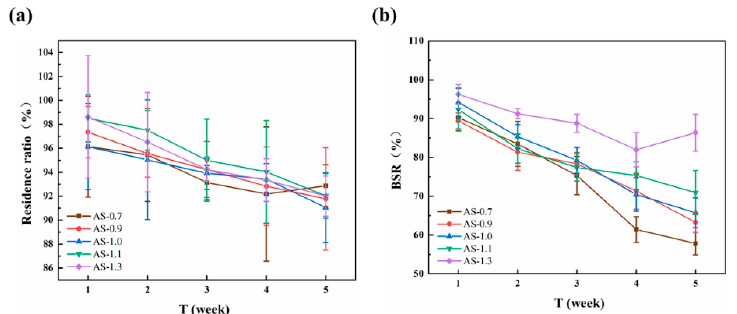
Figure 5. SEM images of chitosan (with different DD) monofilaments with enzymatic hydrolysis for five weeks.